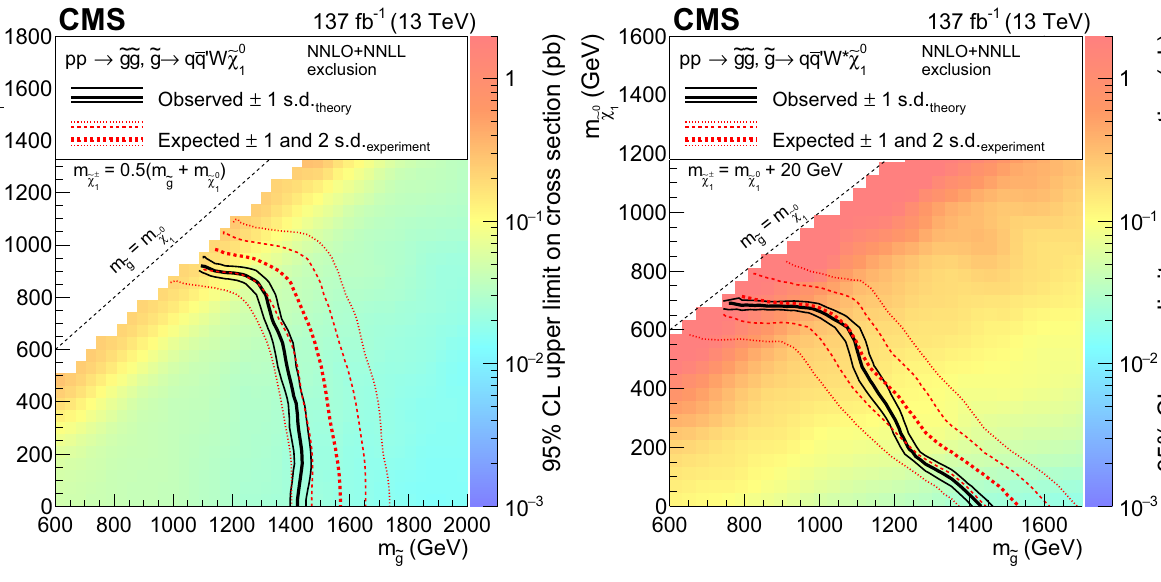
= 0 . 5 ( m ˜ + m ) (left) and with ˜ χ 0 g 1 1